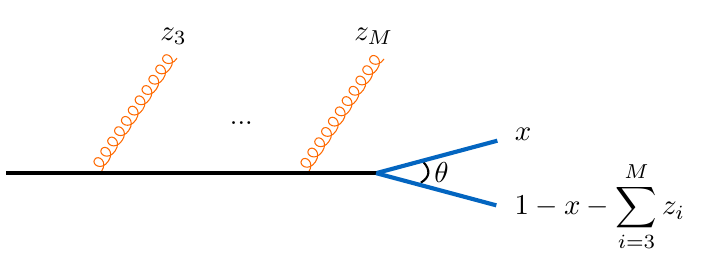
Figure 3. In the 2-collinear (2c) approximation, one can have one collinear emission with mo- mentum fraction x , in addition to collinear-soft emissions, such that the momentum fraction of the initial parton is 1 − x − P z i ≈ 1 − x . The angle between the collinear partons is denoted by i θ ≡ θ 12